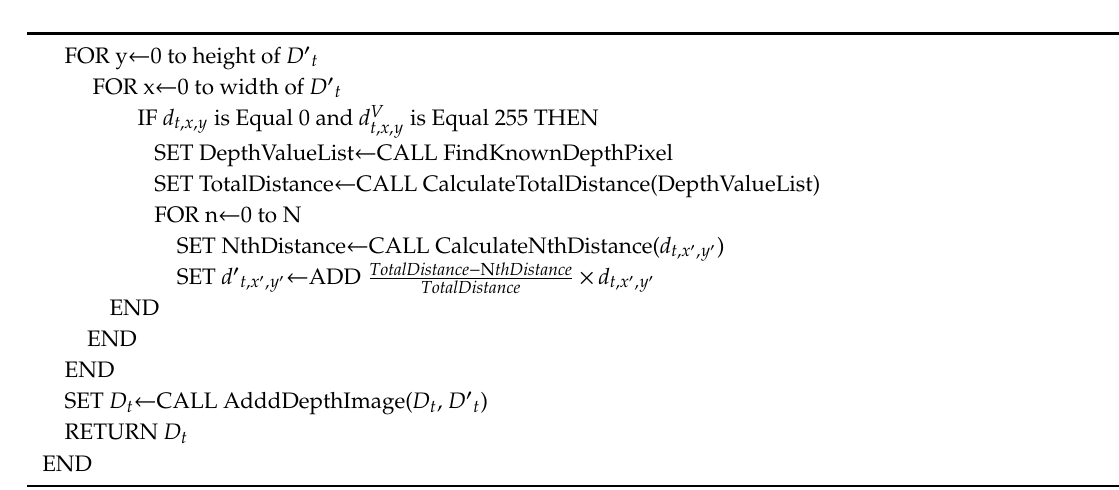
Figure 5. Encoder–decoder model using RGBD image. (cid:1858) (cid:3004) = Φ (cid:3004) (cid:4666)(cid:1829) (cid:3047) (cid:4667)